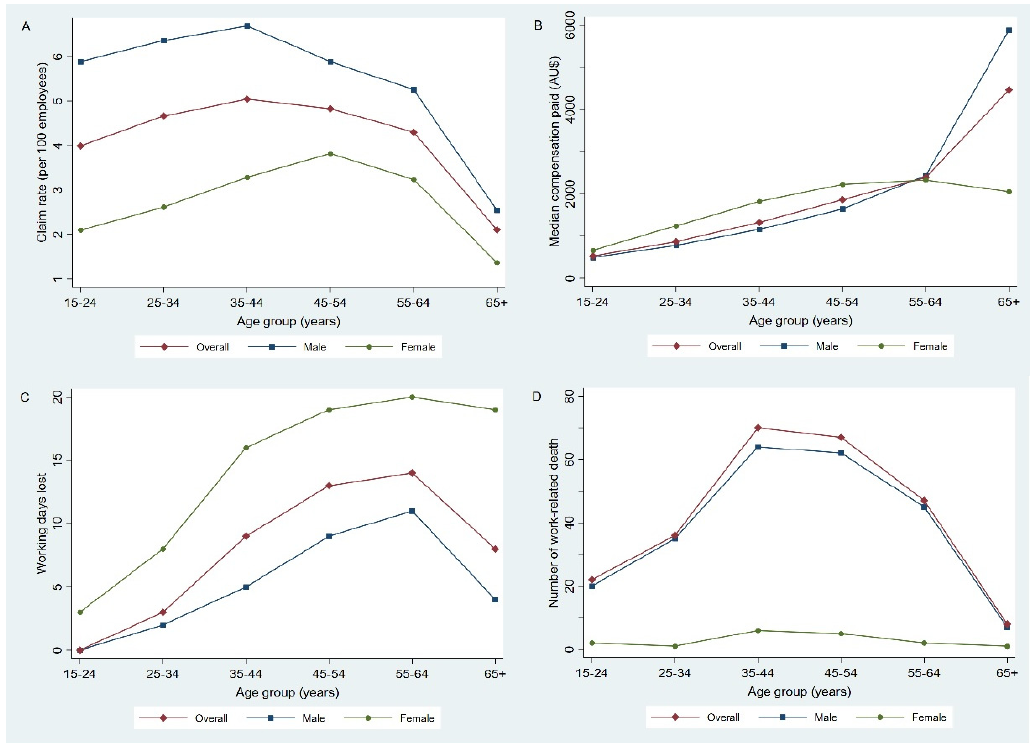
Figure 2. Workers’ compensation claims for 2000–2014 by age group in South Australia showing: ( A ) Age-standardised claim rate, ( B ) median compensation payment, ( C ) interquartile range of working days lost, and ( D ) number of work-related deaths.